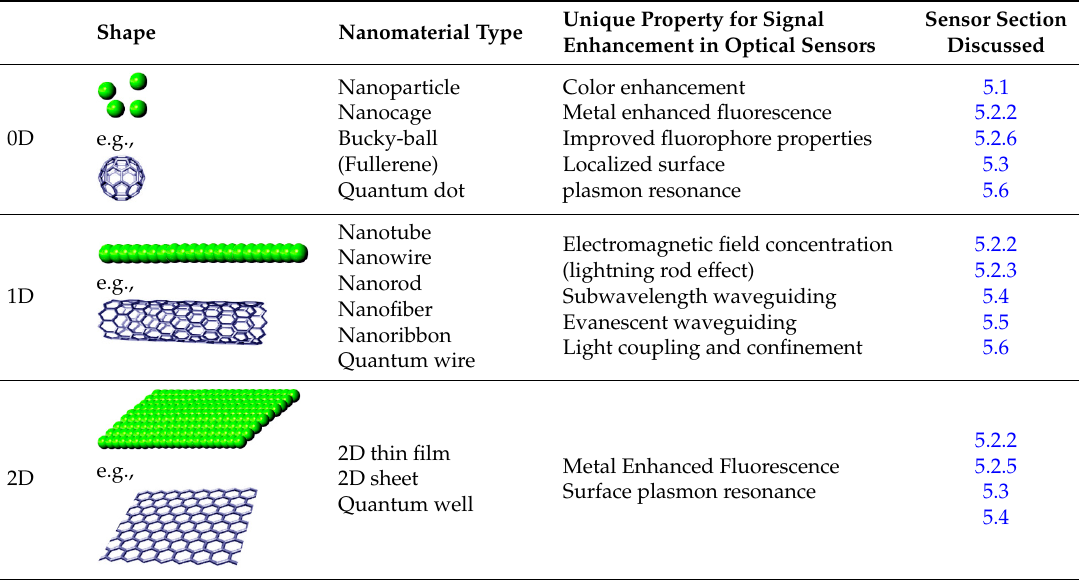
Table 2. Nanomaterials are classified according to their dimensionality along with their unique optical properties leading to signal enhancement in various cytokine sensors to be discussed in the ensuing sections.